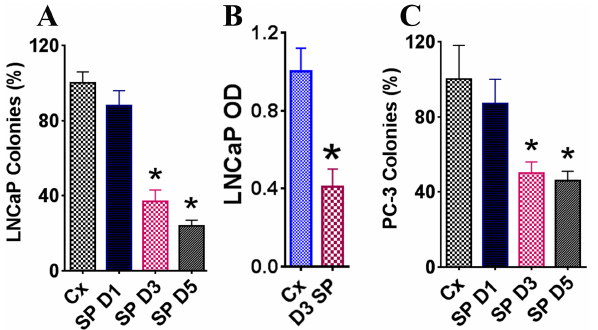
Fig. 1. The time-dependent effect of SARS-CoV-2 SP on LNCaP and PC-3 cell survival. (A) Clonogenic survival assay for LNCaP cells treated with 50 ng/mL of SP for varying peri- ods of time: 1 day (D1), 3 days (D3), 5 days (D5). The control consisted of medium alone with the same concentration of SP and same time periods. Each of the treatment group colonies were quantified and expressed as a percentage of colonies found in the control group. (B) Assessment of the control group and the 3-day (D3) treatment of 50 ng/mL of SP utilizing a cell proliferation kit. Here, two independent experiments are exhibited, and the results are expressed as the average optical density (OD) plus the standard error of the mean (SEM) between the control and SP groups. (C) Clonogenic survival assay for PC-3 cells treated with 50 ng/mL of SP for 1 day (D1), 3 days (D3), 5 days (D5). The control consisted of medium alone with the same concentration of SP and same time periods. Each of the treatment group colonies were quantified and expressed as a percentage of colonies found in the control group. Statistically significant results are indicated by asterisk (*) ( p <